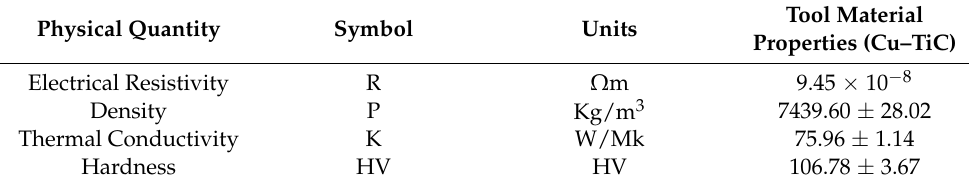
Table 2. Measured properties (average values) of Cu–TiC.